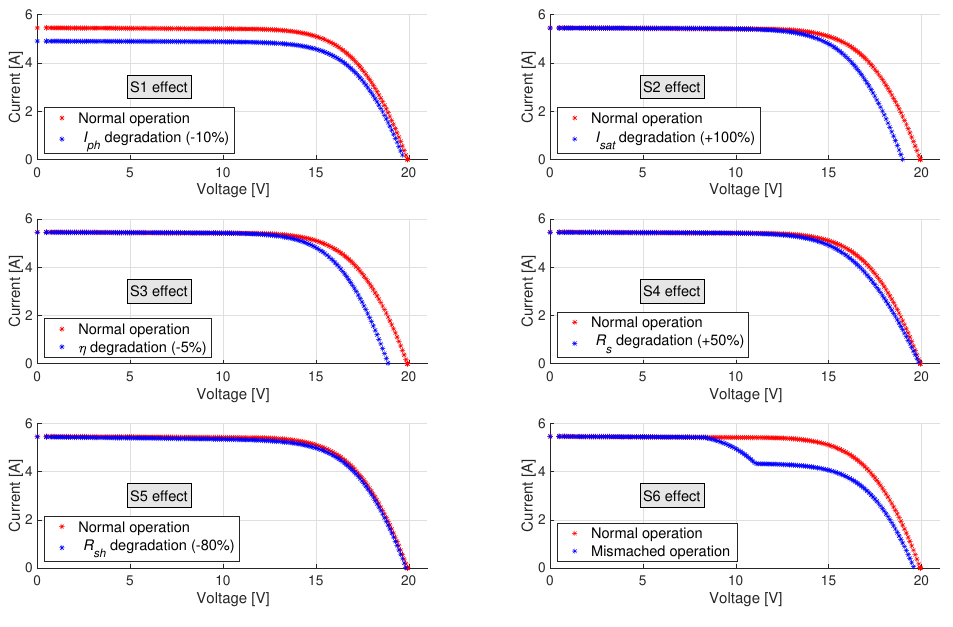
Figure 2. Module failures detectable from the I - V